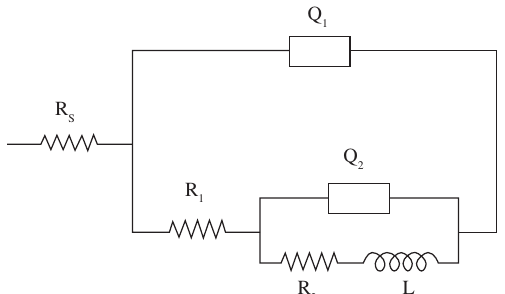
Figure 9. Equivalent circuit obtained of fitting the EIS data of Figure 8 (7 days); Rs (C